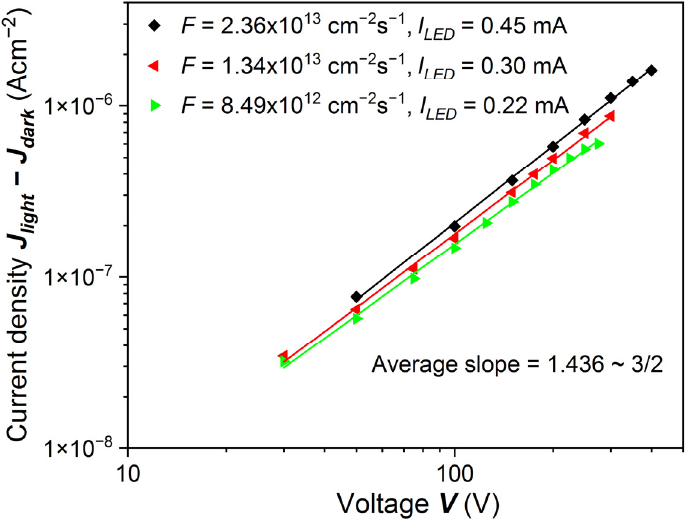
Figure 10. PC-V characteristics from Figure 9 in logarithmic scale. The excitation energy was equal to ħω = 1.651 eV = E g + 76 meV. Photocurrent increased with the bias voltage roughly like V 3/2 . When the current is inversely proportional to the cross section for Coulomb trapping, it should depend on the electric field like E 3/2 [23–26].